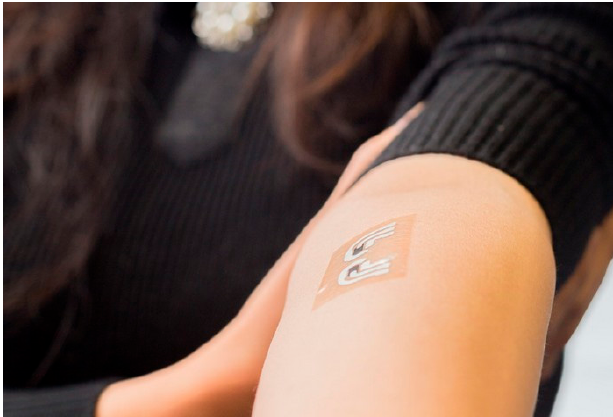
Figure 13. Epidermal electronic tattoo. Copyright © 2014. Jacobs School of Engineering/UC San Diego.